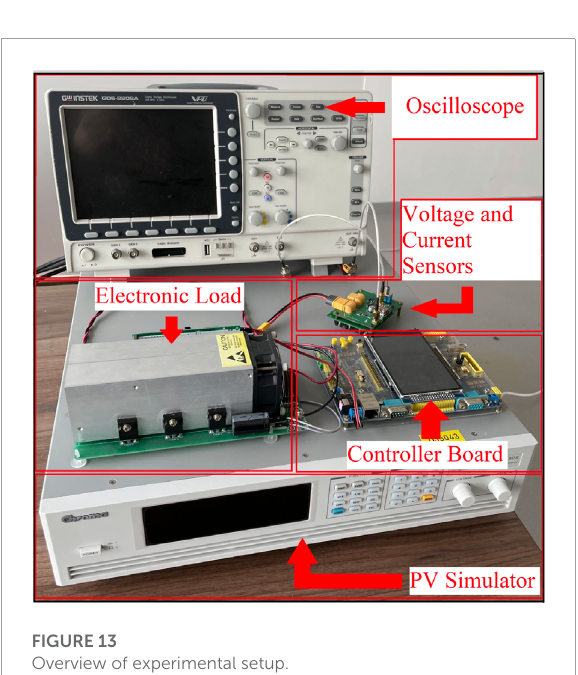
FIGURE 13 Overview of experimental